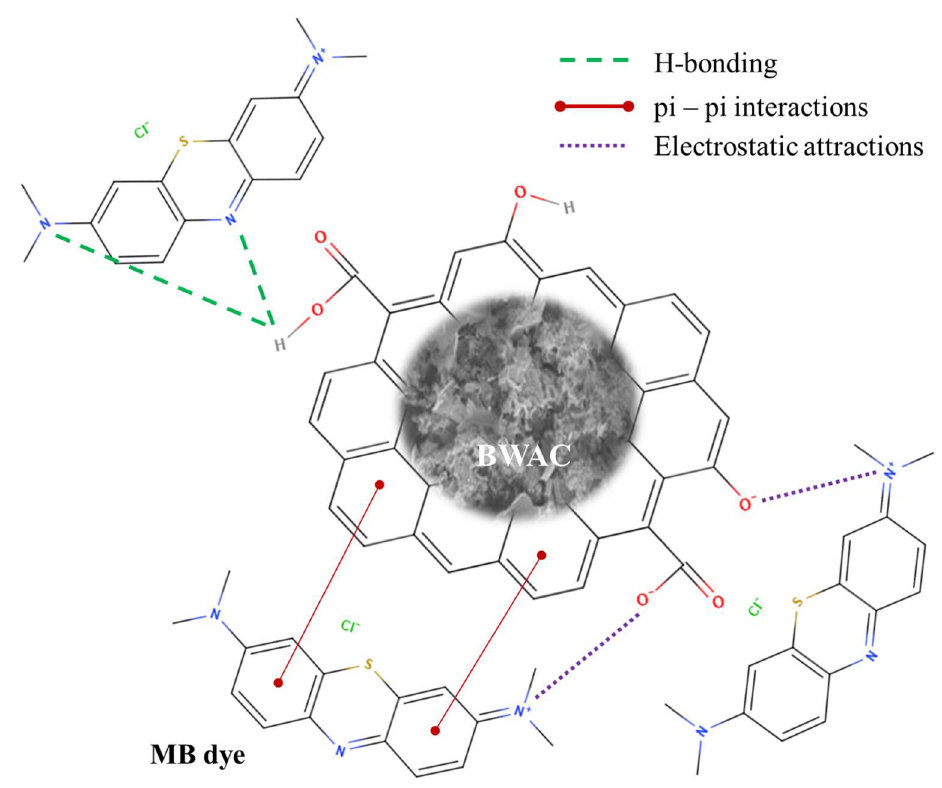
Figure 10. Illustration of the possible interactions between BWAC’s surface and MB including electrostatic attractions, hydrogen bonding, and pi–pi interactions.